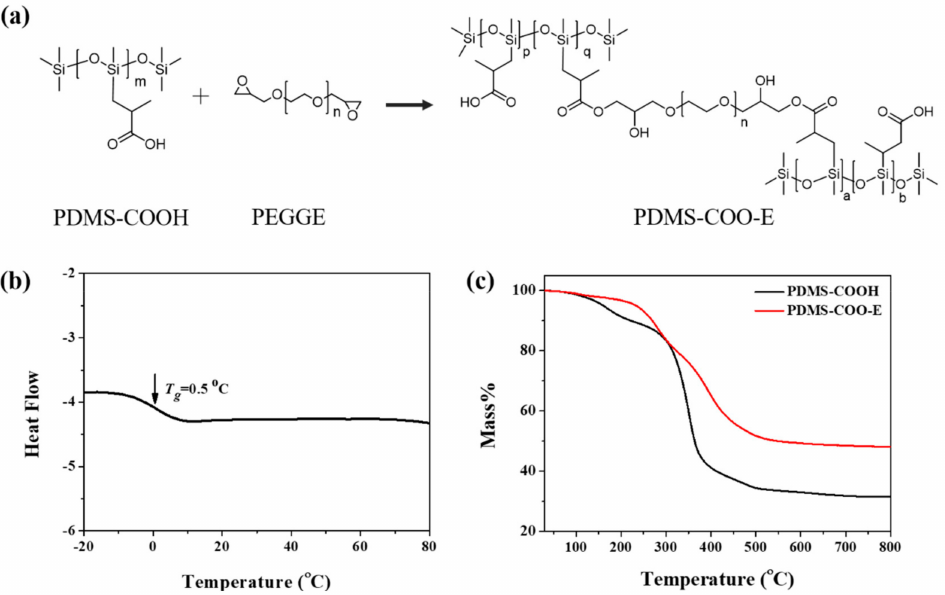
Figure 1. ( a ) Synthesis route of PDMS-COO-E polymer. ( b ) The DSC curve of PDMS-COO-E polymer. ( c ) The TGA curves of PDMS-COOH and PDMS-COO-E